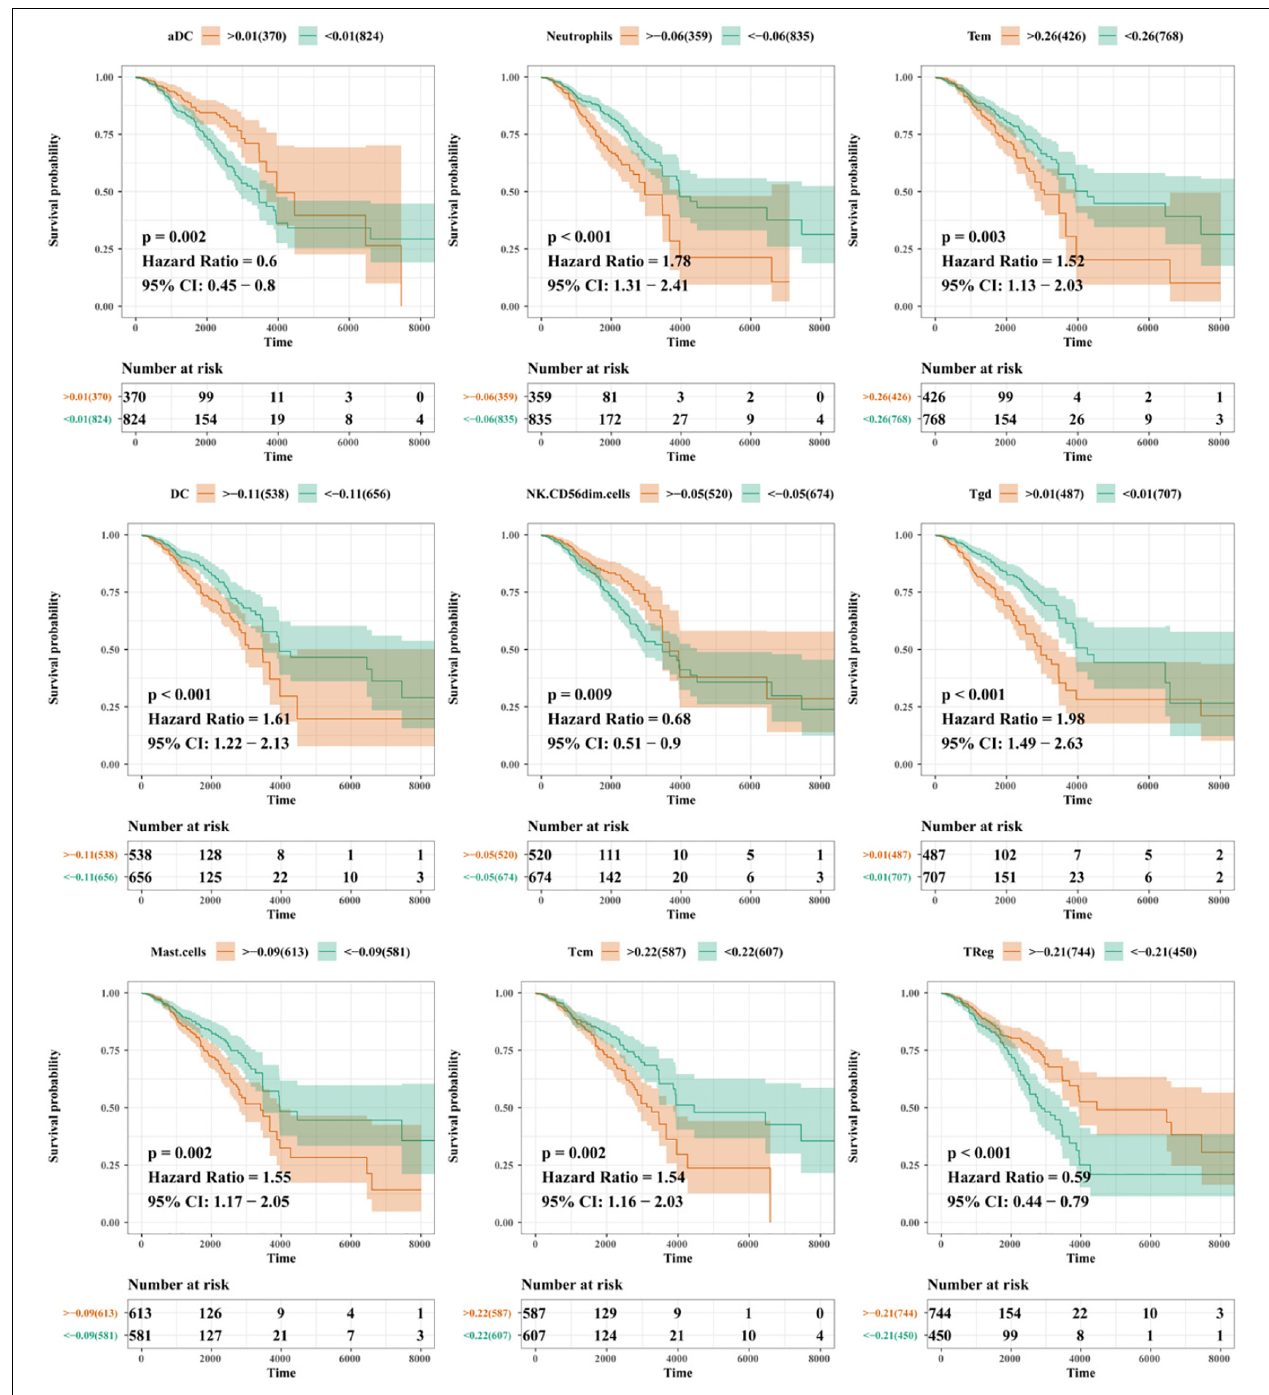
FIGURE 12 | Prognosis analysis for immune